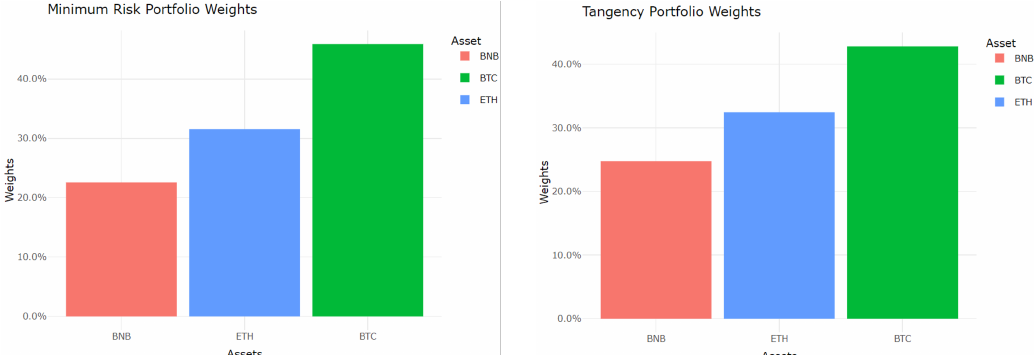
Figure 10. The asset weights assigned using MRP-VESV and MMRP-VESV for Stock Assets.